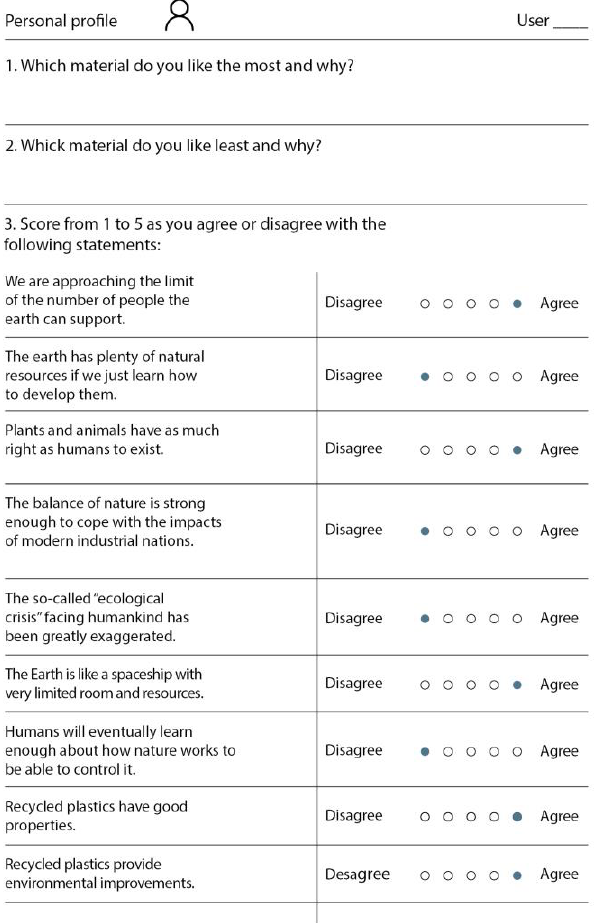
Figure 6. Environmental attitude questionnaire. A blue circle is used to show the answer that is associated with a better environmental attitude.